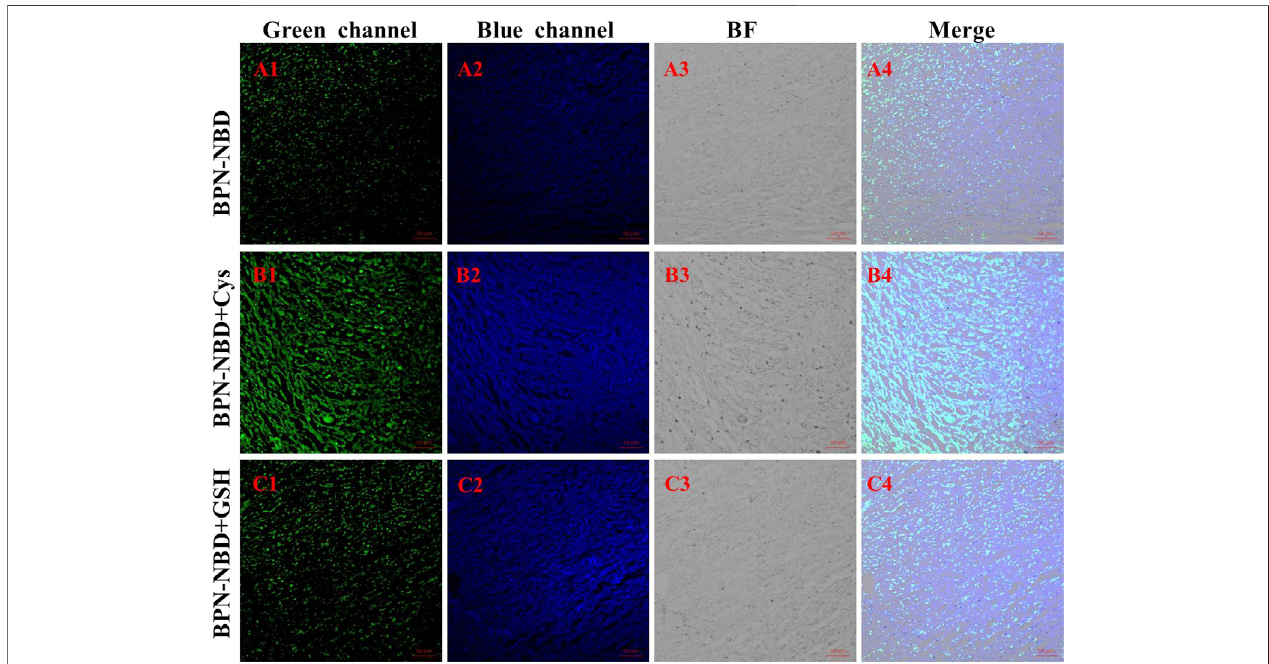
FIGURE 6| The tumor tissue imaging (at the green and blue channels) of endogenous and exogenousCys/GSH in BALB/cmice. (A) Only with treatment by BPN- NBD (50.0 µM). (B) By staining with Cys (200.0 µM) and BPN-NBD (50.0 µM). (C) By dealing with GSH (200.0 µM) and BPN-NBD (50.0 µM). Emissions were collected at 425 – 475 nm for the blue channel (excitation wavelength: 405 nm) and 515 – 550 nm for the green channel (excitation wavelength: 488 nm). Scale bar: 50 µm.